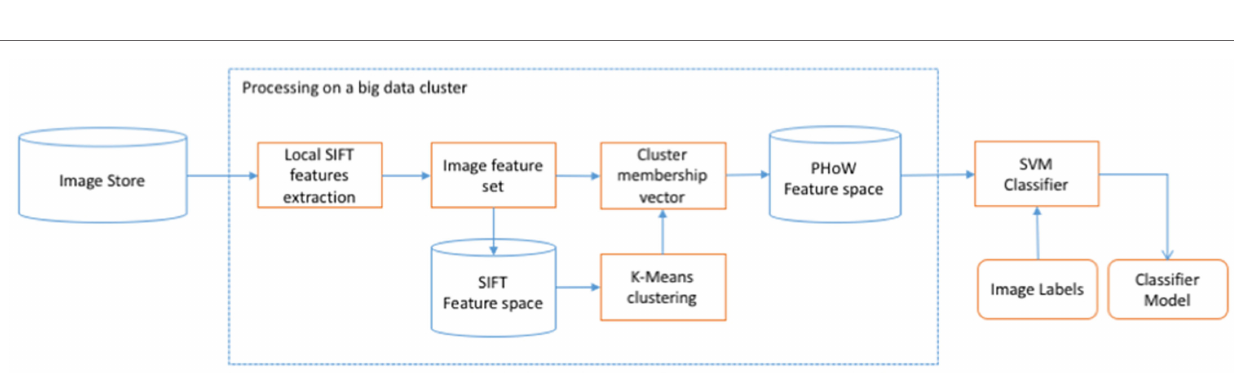
FIgURe 3 | conceptual implementation of “classifier training” block with “phoW with SVM” classifier .